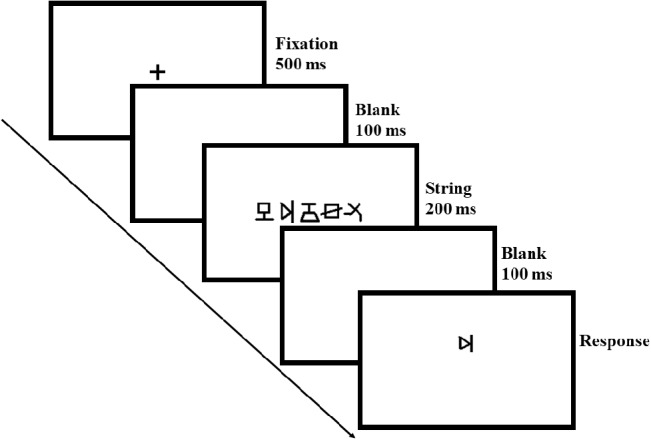
The presentation format of each trial in the visual 1-blank task. In each trail, a 500-ms fixation was first presented in the screen center, and then there was a 100-ms blank, which was followed by a probe of the five-figure string centering on the screen for 200 ms. The string was replaced by a 100-ms blank, and finally, the target of a single figure appeared below or above (half of the trails) the median horizontal line. Participants were asked to press different keys to judge whether the target figure was present in the above string or not.